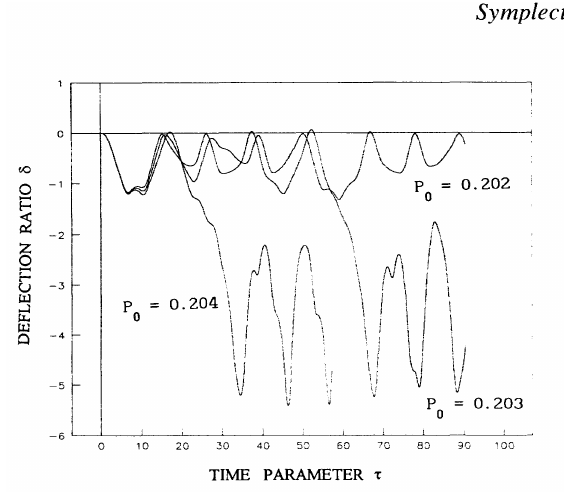
FIGURE 8 Dynamic snap-through of a shallow cir cular arch.